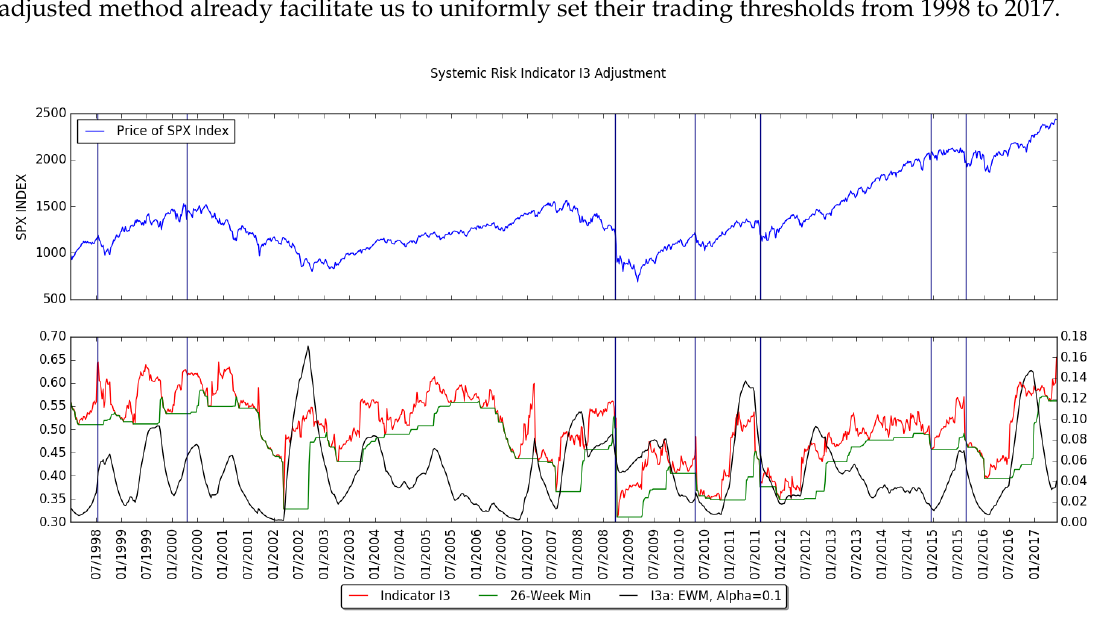
Figure 12. Systemic Risk Indicator I 3 a